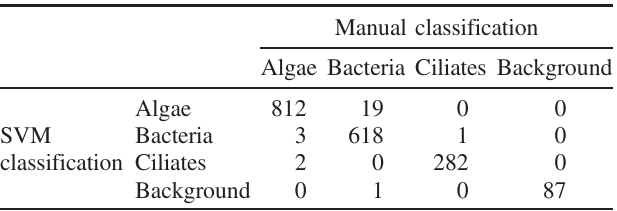
TABLE I. Classification